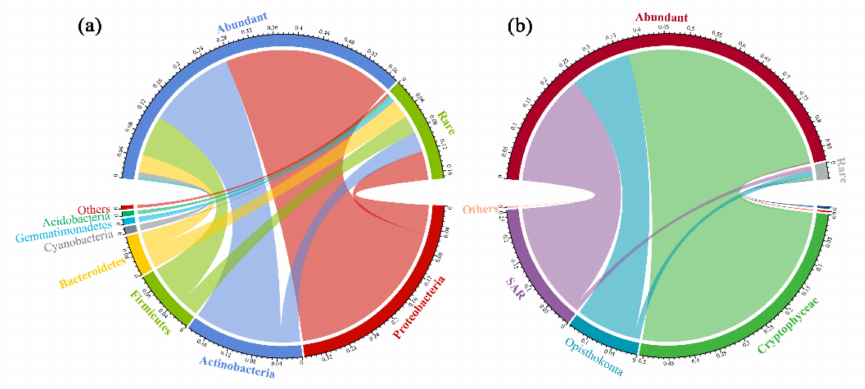
Figure 2. Chord plots showing the taxonomic distribution of the abundant and rare taxa of bacteria ( a ) and microeukaryotes ( b ). The thickness of each ribbon represents the numbers of abundant and rare